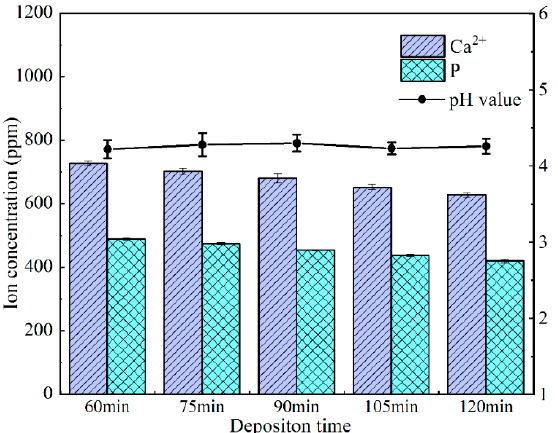
Figure 4. Calcium ion concentration, total phosphorus content and pH value of electrolyte as related to deposition time during electrodeposition.